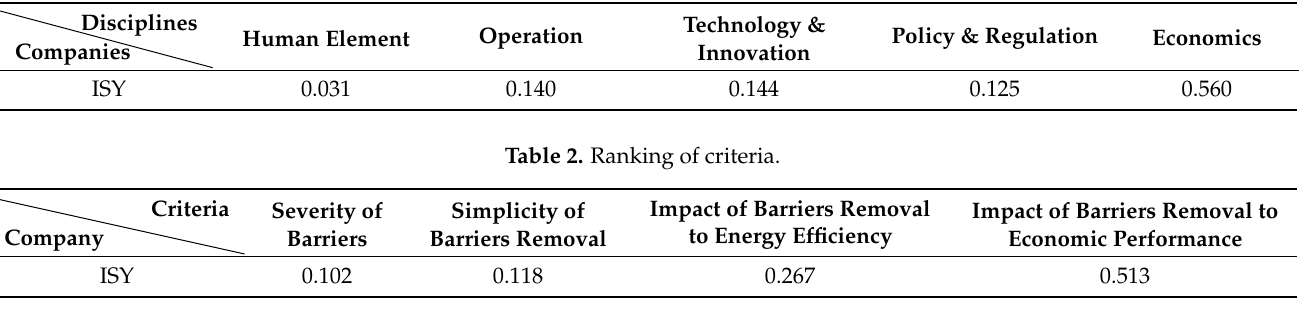
Table 1. Ranking of disciplines.